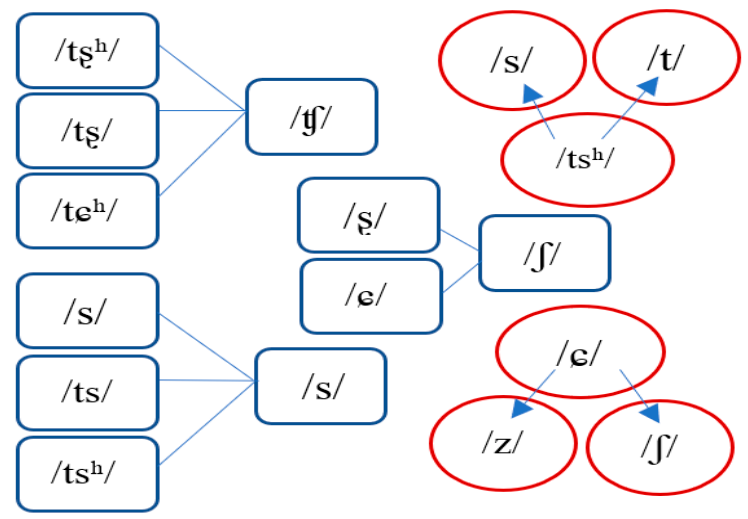
Figure 2. Mandarin to English sound mapping patterns by English listeners; 3 to 1 and 2 to 1 mappings are in blue squares and 1 to 2 mappings are in red circles.